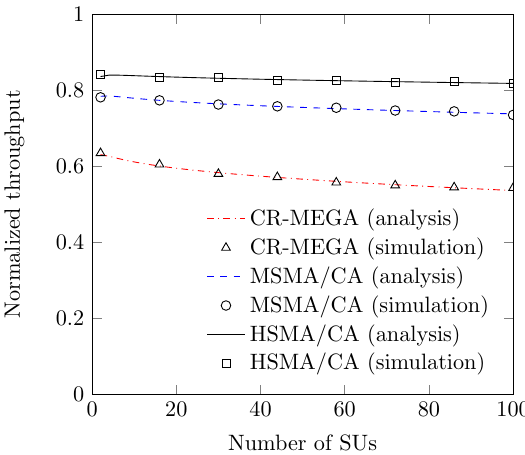
Figure 11. Normalized throughput vs. number of